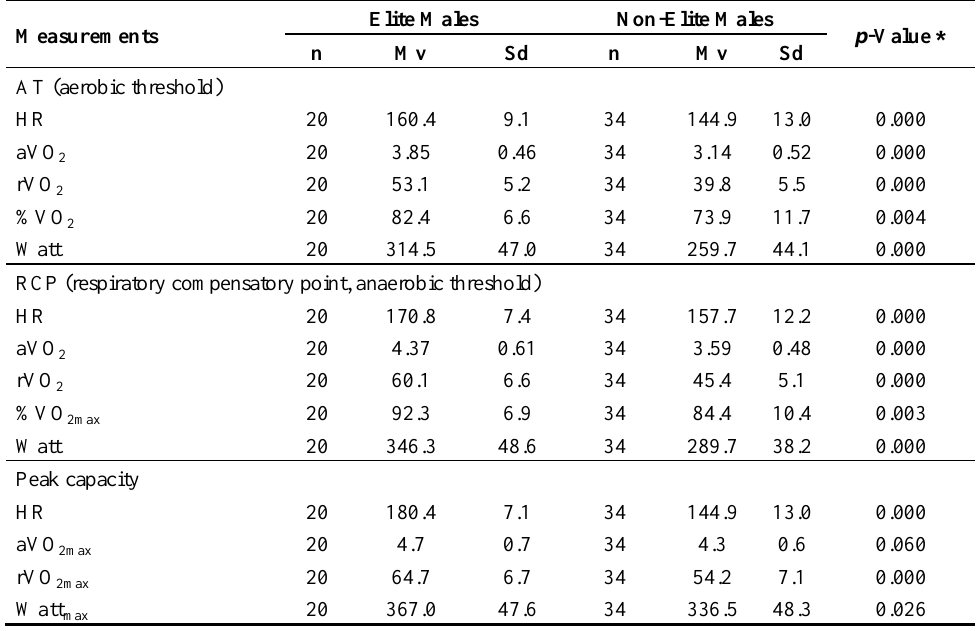
Table 5. Males: heart rate, oxygen uptake and power output according to performance. Elite Males Measurements AT (aerobic threshold)